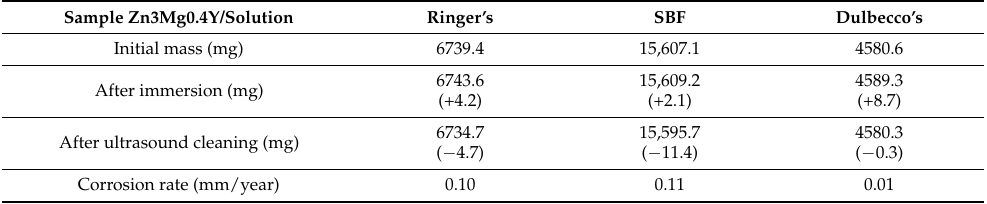
Table 3. Mass variation and corrosion rate of ZnMgY alloy in three different solutions (3 days immersion).